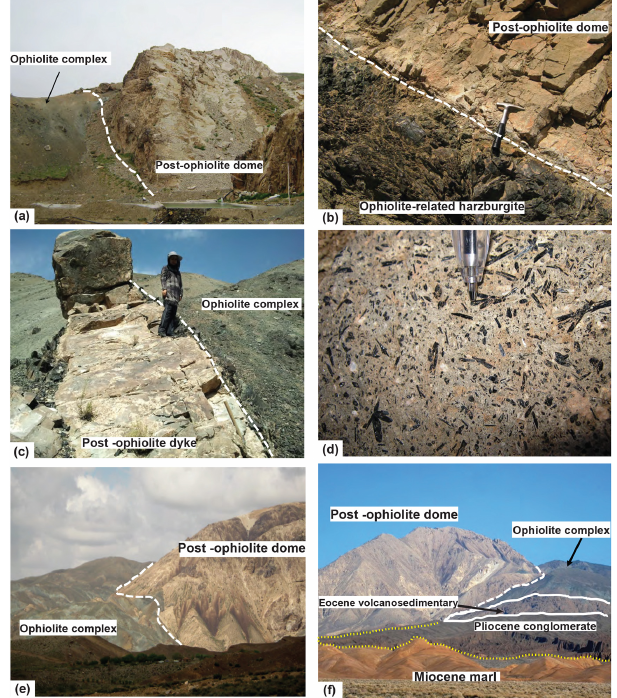
Figure 2. Field photographs. (a) and (b) Northern grey dome of trachydacite exposed in ophiolite-related harzburgite. (b) Contact between post-ophiolite subvolcanic rock and host harzburgite. (c) Post-ophiolite dyke in the northern sector. (d) Presence of star-shape amphibole aggregates in the andesitic dyke. (e) and (f) Southern post-ophiolite domes that outcrop in the ophiolite complex. Eocene volcaniclastic complex, Miocene sedimentary and Pliocene con- glomerates are seen in (f) .